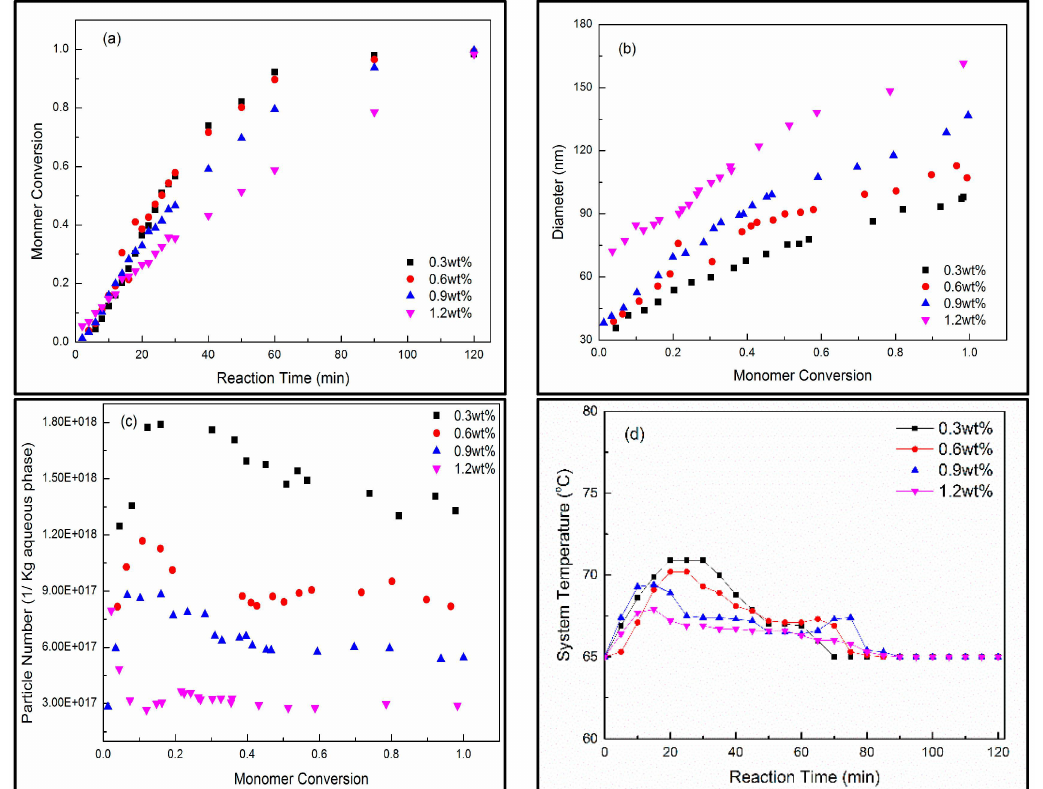
Figure 2. Plots of monomer conversion ( a ); particle size ( b ); number ( c ); and system